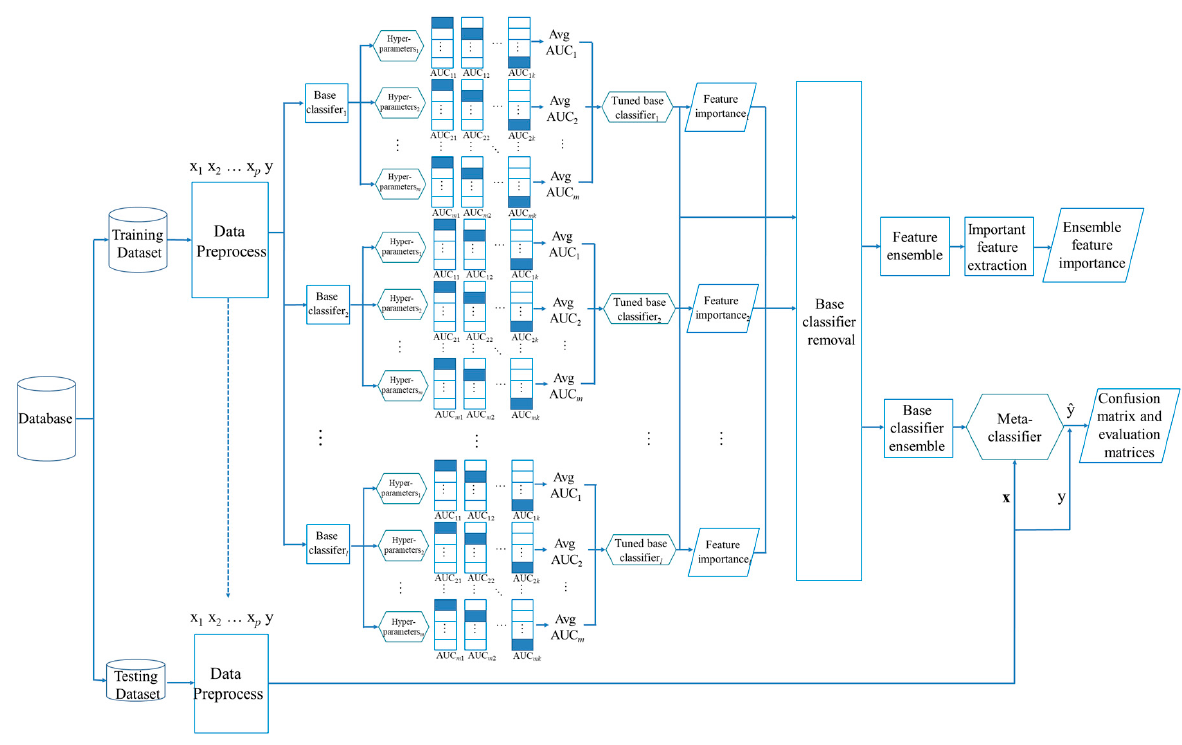
Figure 1. The overall flowchart of the proposed method, in which p, l , k, and m mean number of features, number of base classifiers, number of folds, and number of random values to try for each tuning